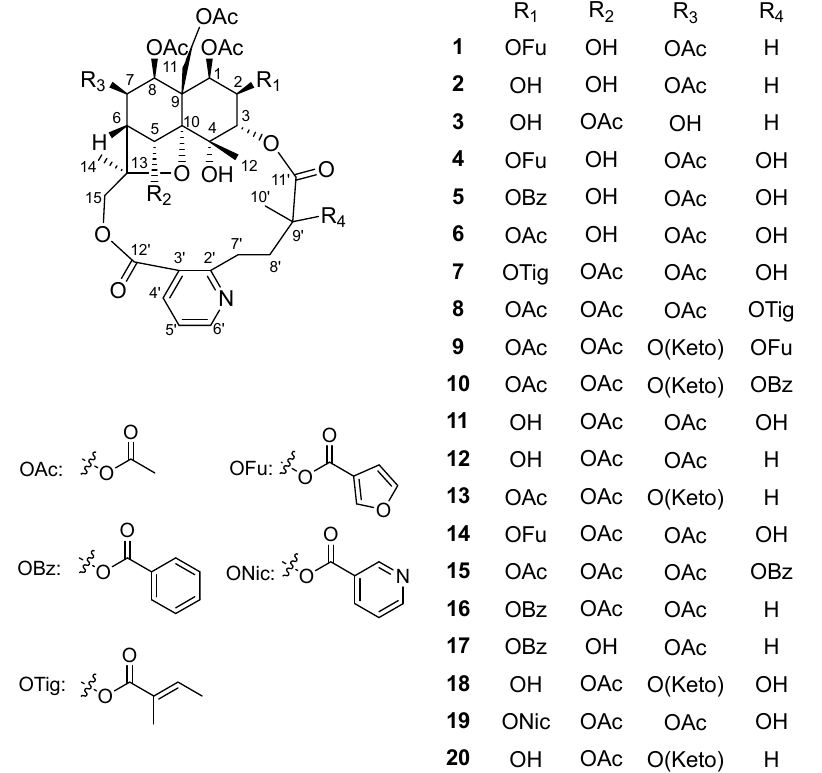
Figure 1. Chemical structures of the isolated SPAs ( 1 – 20 ).